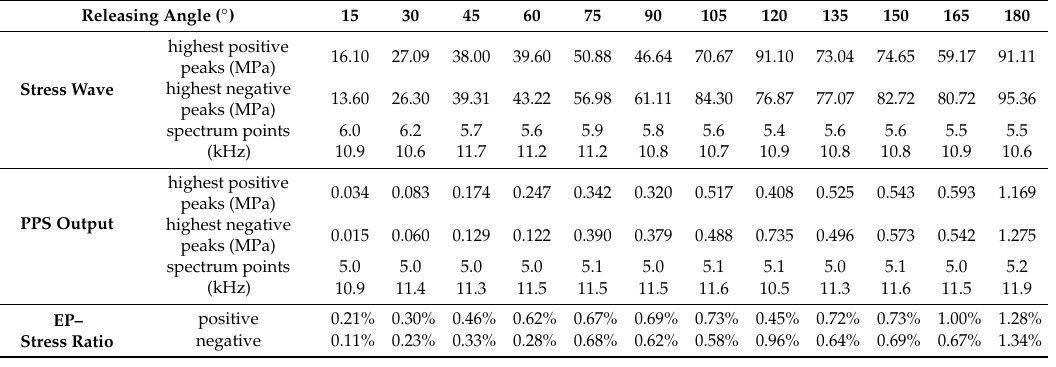
Table 1. Stress wave e ff ect (SWE) experimental data.